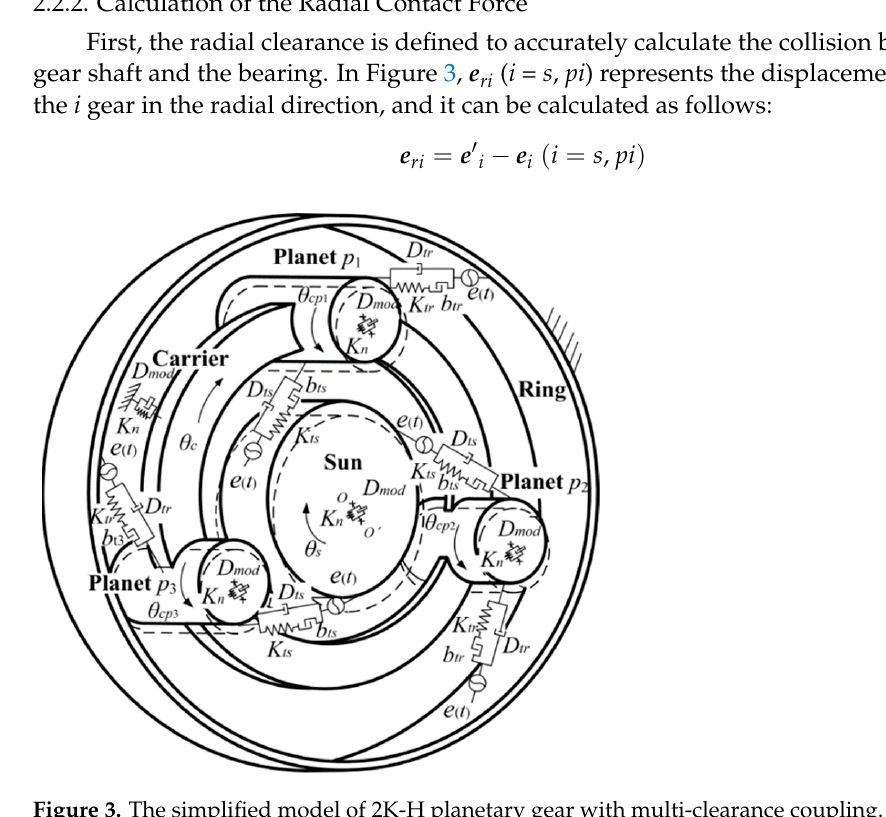
Figure 3. The simplified model of 2K-H planetary gear with multi-clearance coupling.